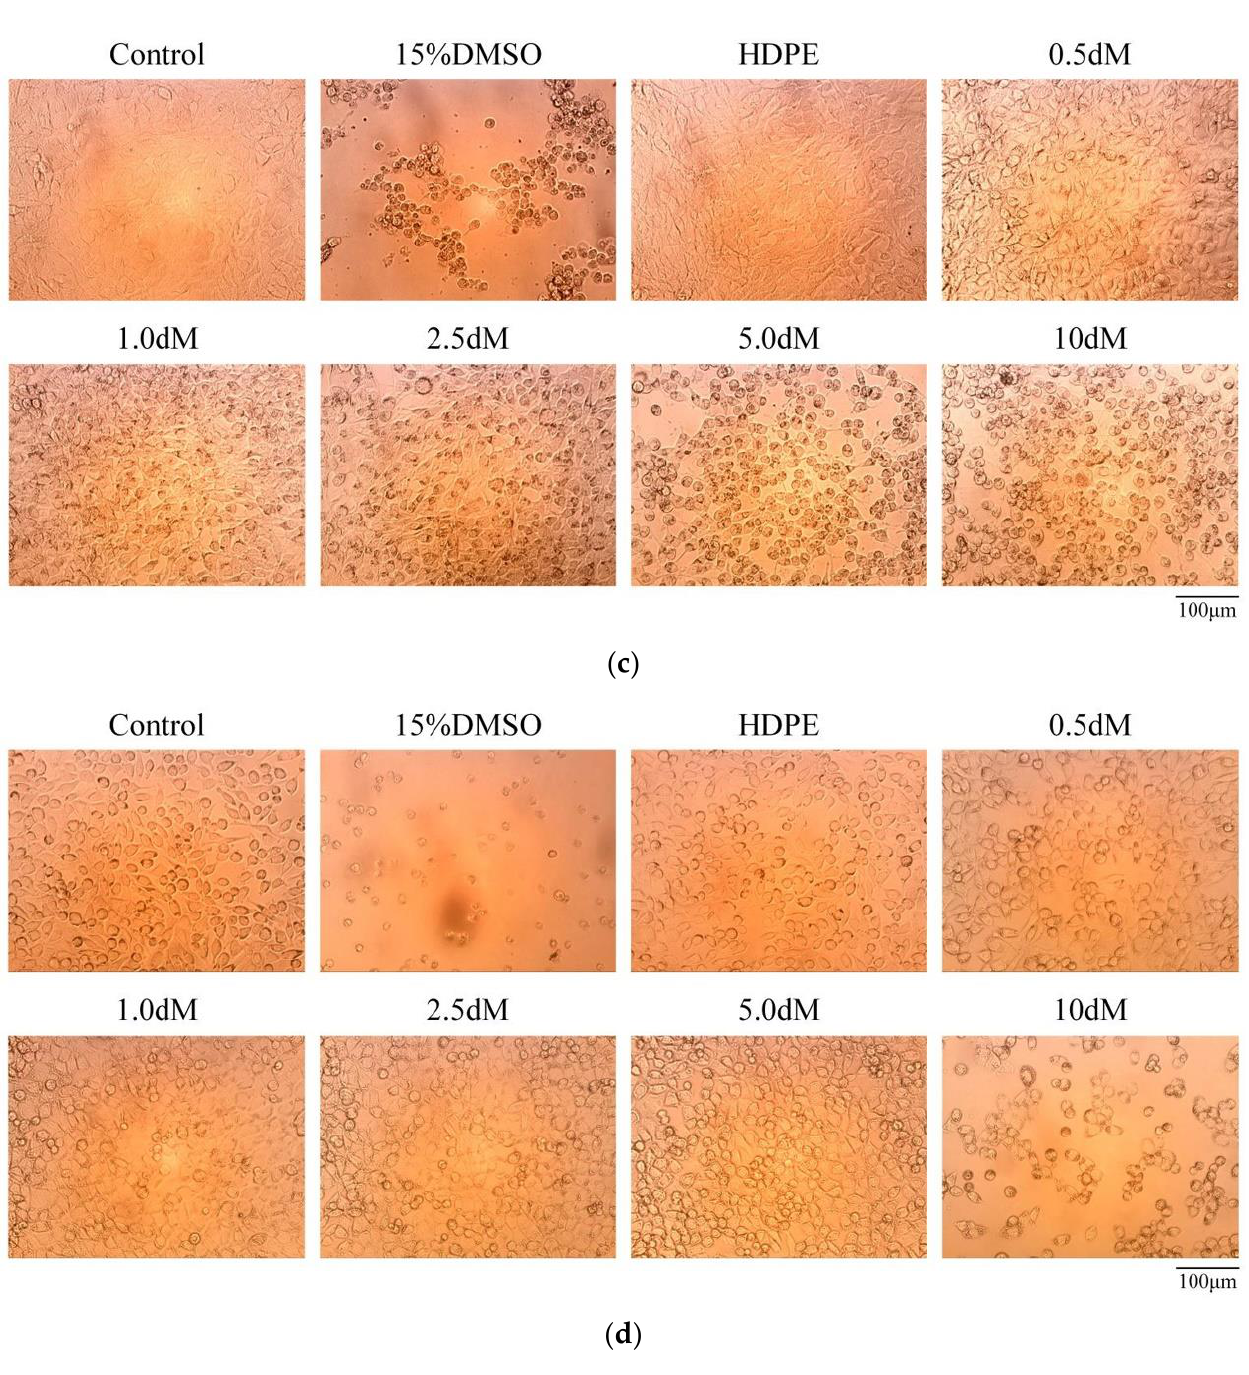
Figure 2. Cytotoxicity of modified microspheres with different concentrations of DAP ( a ) 3T3 and ( b ) L929 ( n = 3) and qualitative observation of ( c ) 3T3 and ( d ) L929 cell lines.